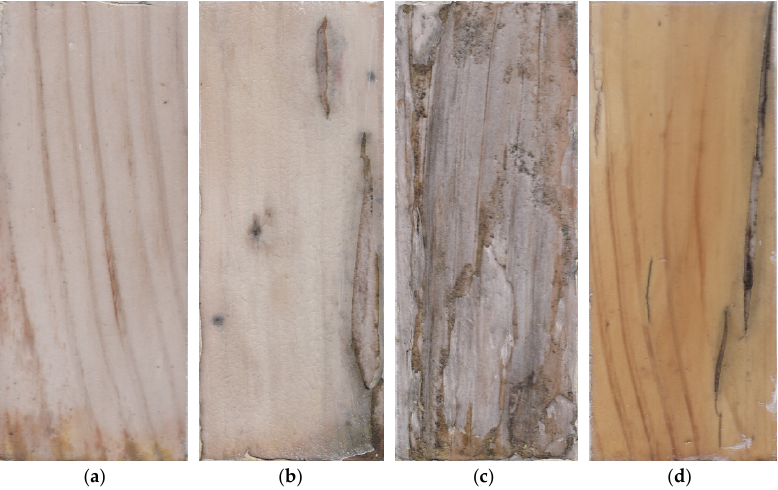
Figure 9. Appearance of clear coatings on untreated radiata pine panels exposed to the weather for 4 years: ( a ) acrylic; ( b ) alkyd; ( c ) water-based spar varnish; ( d ) solvent-based spar varnish.